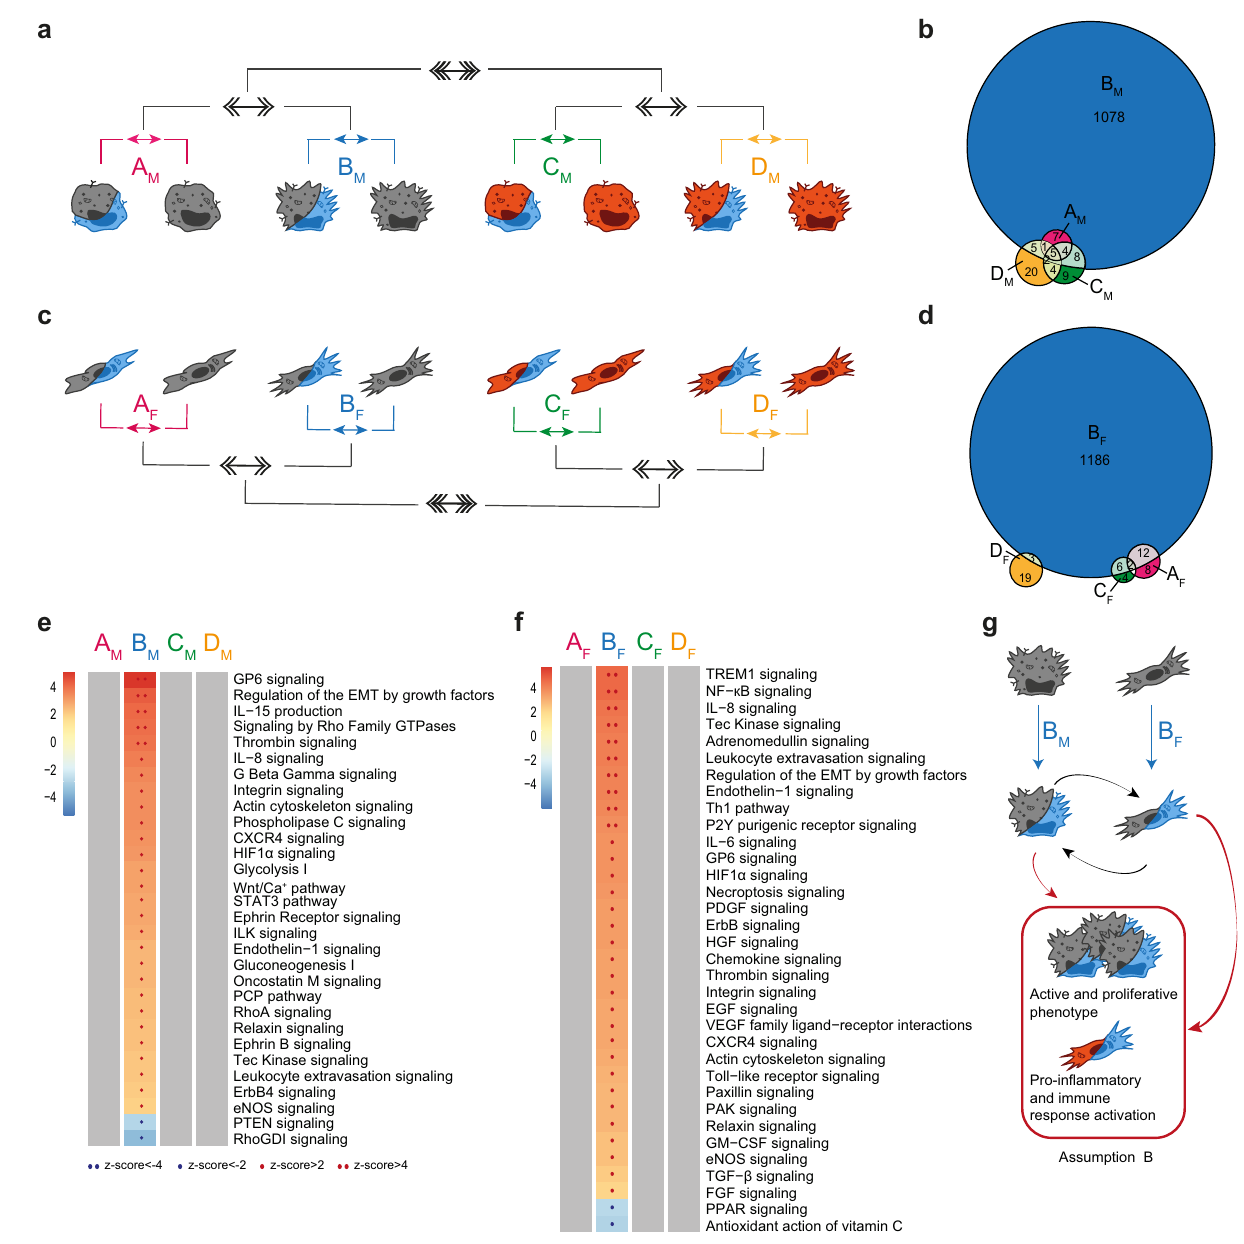
Fig. 4 | Role of hypoxia on the global biological response. a , c Schematic representation of the multi-level approach to study the effect of hypoxia on M φ ( a , b , e ) and Fb ( c , d , f ) in different immune and culture conditions. 1st level compares hypoxic cells to normoxic cells in four different conditions: resting and single culture (comparison A M /A F in pink), resting and coculture (B M /B F in blue), LPS+IFN γ and single culture (C M /C F in green), LPS+IFN γ and coculture (D M /D F in yellow);2nd level (double arrows)comparescocultureto singlecultureconditions (AvsB and CvsD); 3rd level (triple arrows) compares resting to proin fl ammatory conditions [(A+B)vs(C+D)]. b , d Venn diagrams with DEGs distribution in each 1st